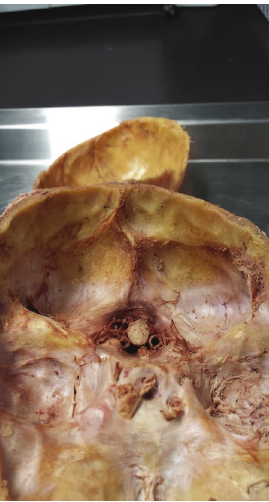
Figure1:Dissectionoftheskullbymakinghorizontalcutstoexpose internal bony landmarks.